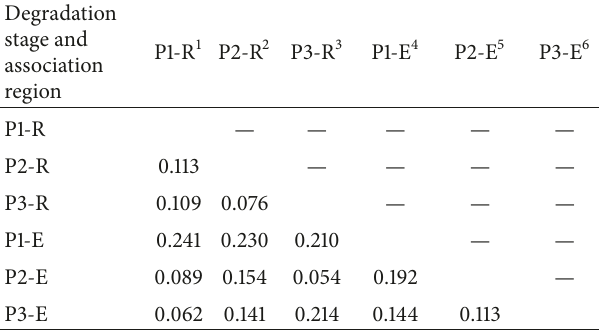
Table 3: 𝑅 values of the analysis of similarity of the diversity of the cultivated diazotrophic bacterial community determined through Polymerase Chain Reaction (BOX-PCR) in different niches of plant/ bacteriaassociationin B. decumbens Stapf.pastureindifferentstages of degradation.